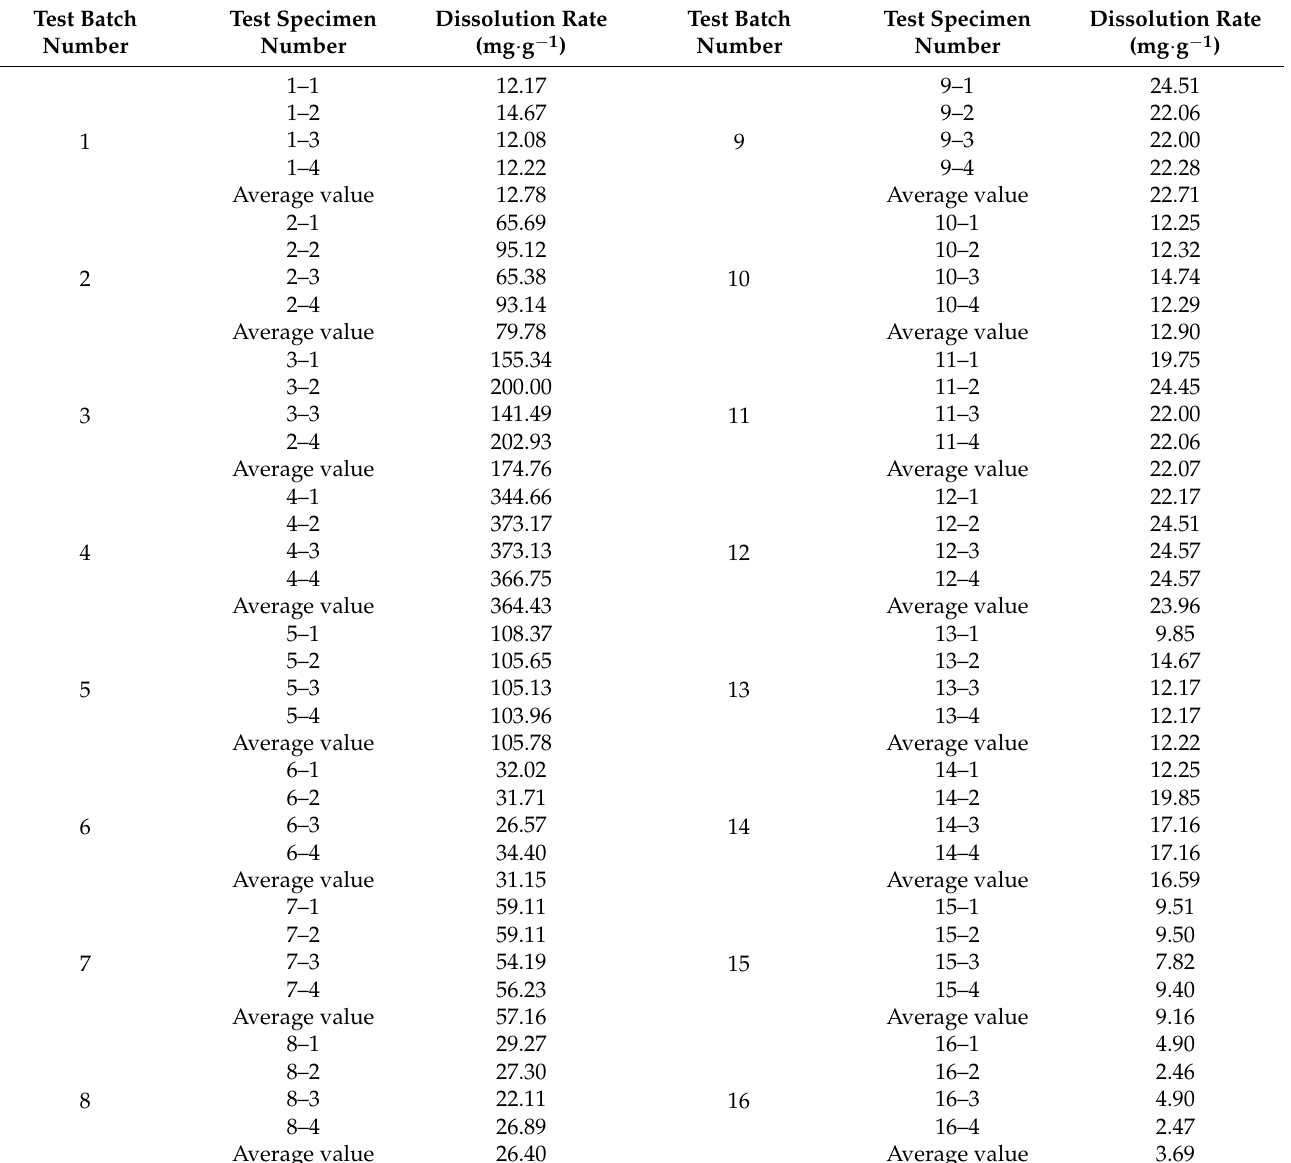
Table 5. Orthogonal test